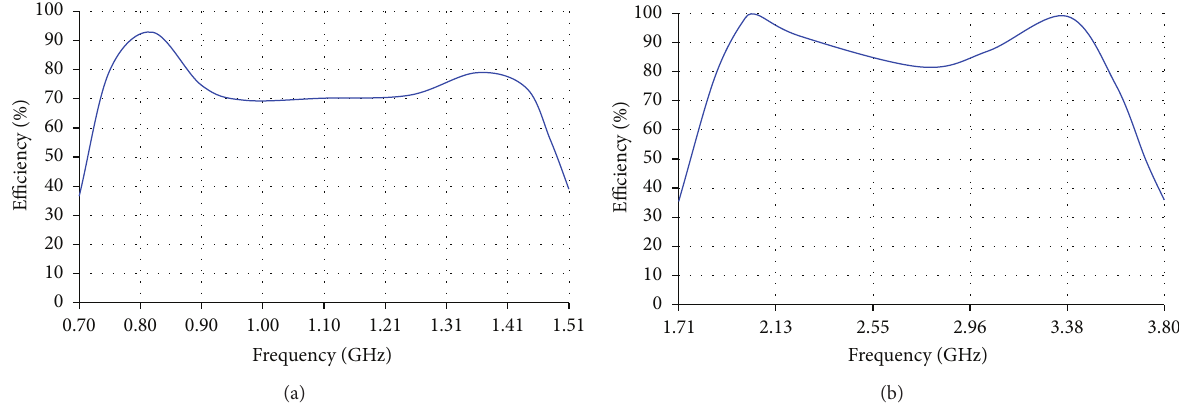
Figure 7: Efficiency of (a) the reduced size version of the low band antenna and (b) the reduced size version of the high band antenna.